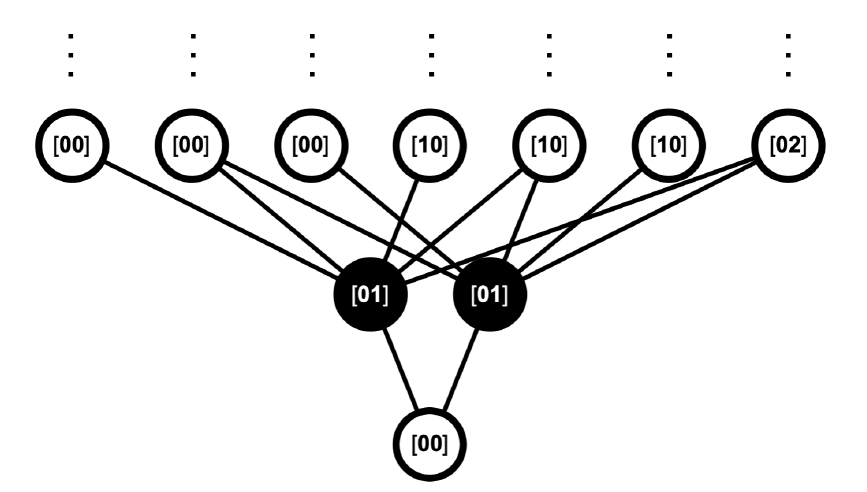
Figure 15 . Adynkra Diagram for 5D minimal scalar